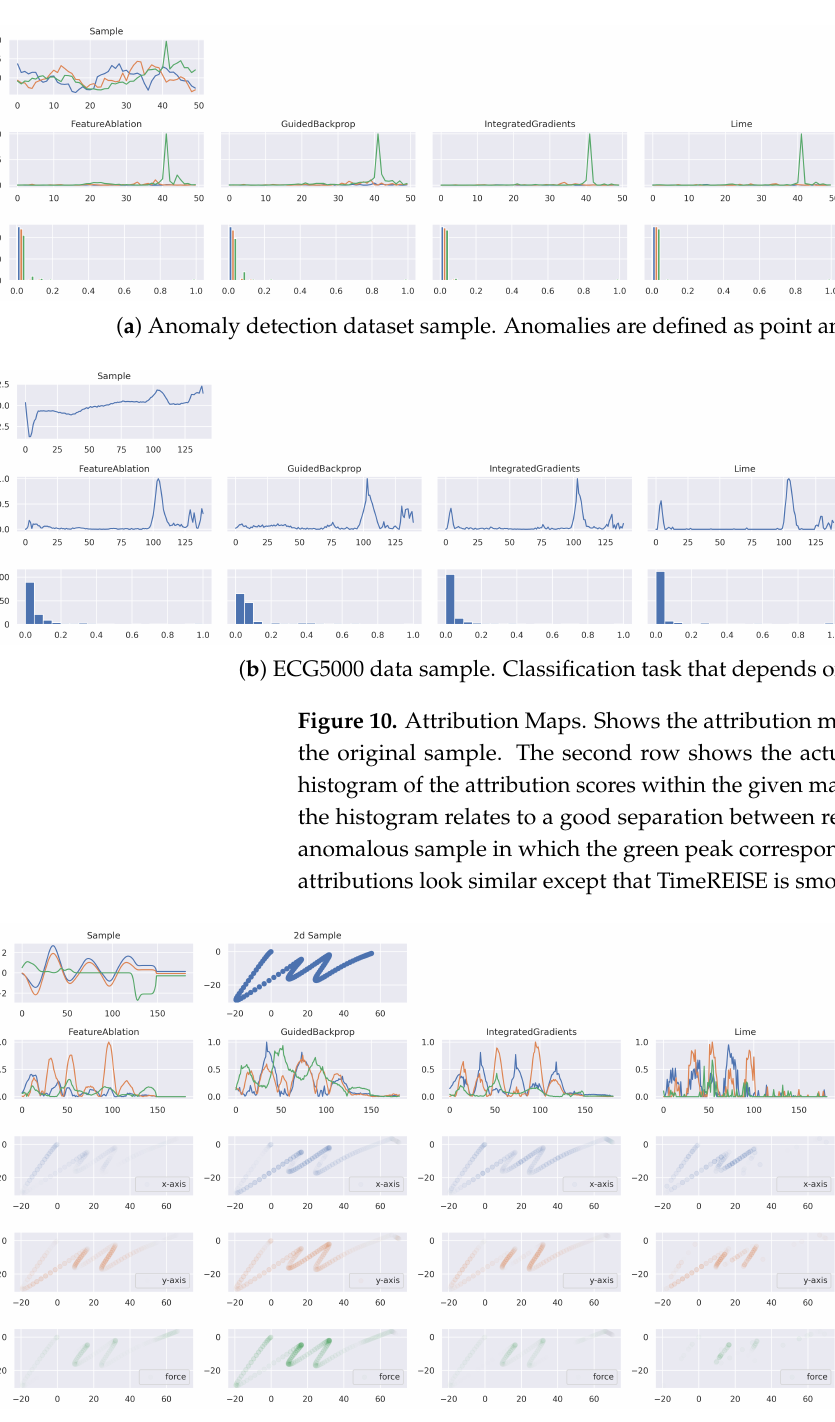
Figure 11. Explainable Attribution. The first row shows the time series of the character example ‘m’. The right plot corresponds to the back transformation to the original 2d space. The second row shows the attribution results for each method. The subsequent rows show the importance applied to the character for the horizontal and vertical direction as well as for the force. TimeREISE provides a smooth attribution map and assigns importance to the force channel. Besides TimeREISE, only GuidedBackprop highlights the importance of the force